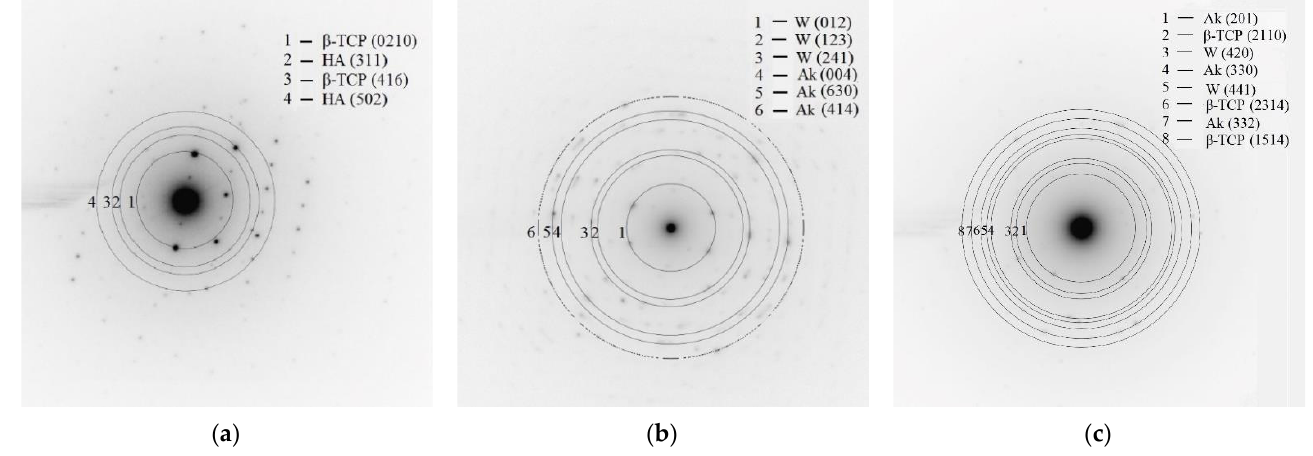
Figure 9. Micro-diffraction patterns of the fragments of the TC ( a ), WS ( b ), and TW ( c ) coatings. β - TCP —β tricalcium phosphate, HA— hydroxyapatite, W — wollastonite, Ak — akermanite.